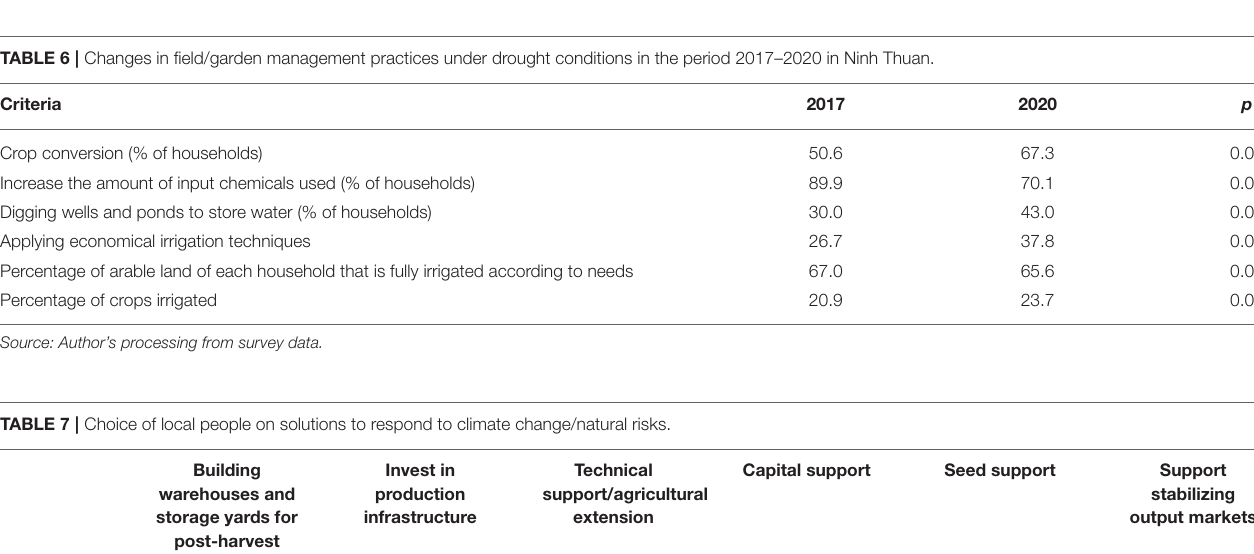
Plant cover crops/cover crops to improve soil nutrition and retain soil moisture